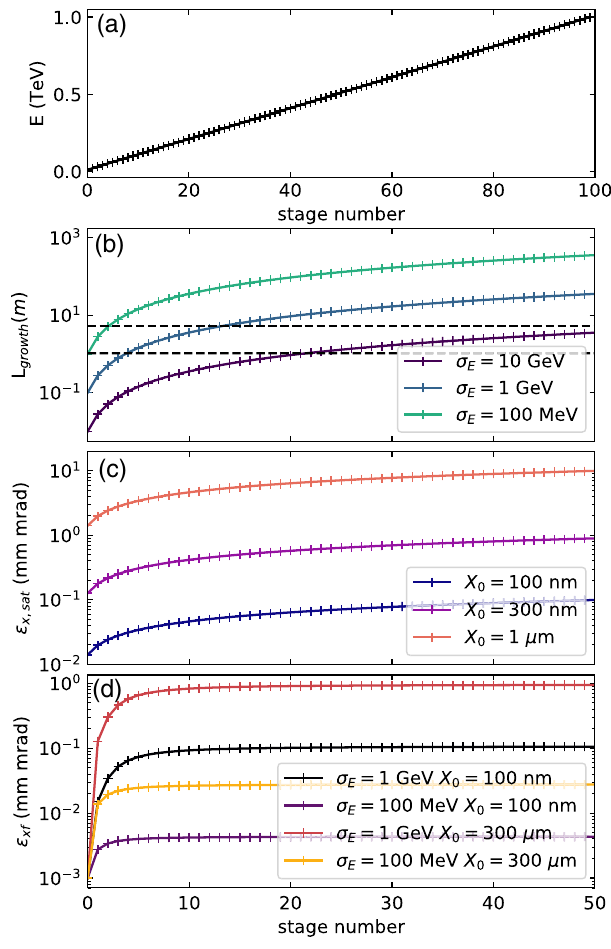
FIG. 11. Effect of misalignment on each stage of a 1 TeV collider for a beam with initial emittance ϵ x 0 ¼ 10 − 3 mm mrad. (a) Energy at the end of each stage. (b) Characteristic length for emittance growth due to phase mixing in the presence of ¼ c= 2 ν . Cases of 0.1, misalignment within each stage L growth 1, and 10 GeV energy spread, i.e., 0.01%, 0.1%, and 1% of the final energy, respectively, were considered. The bottom dashed line shows the stage length L . The top dashed line shows stage 5 × L > 5 × L . When L , the beam is rigid and the stage growth stage emittance does not evolve within each stage. (c) Saturated value for the emittance given by Eq. (23) for different values of initial offsets. The beam enters each stage with the same offset X 0 . The laser propagates on axis. (d) Emittance at the end of each stage given by Eq. (23), for ¯ x 0 ¼ 0 and two values of energy